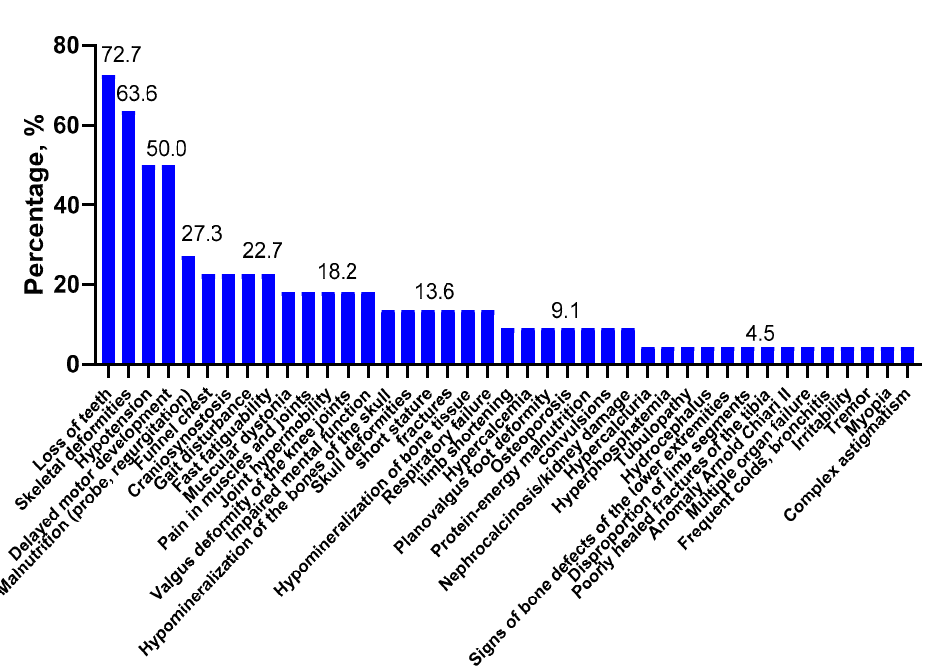
Figure 1. Clinical symptoms of HPP in the ALPL gene for patients with two pathogenic variants and within the Russian population ( n = 22). The numbers above the columns indicate the percentage of the manifestation of the clinical symptom.